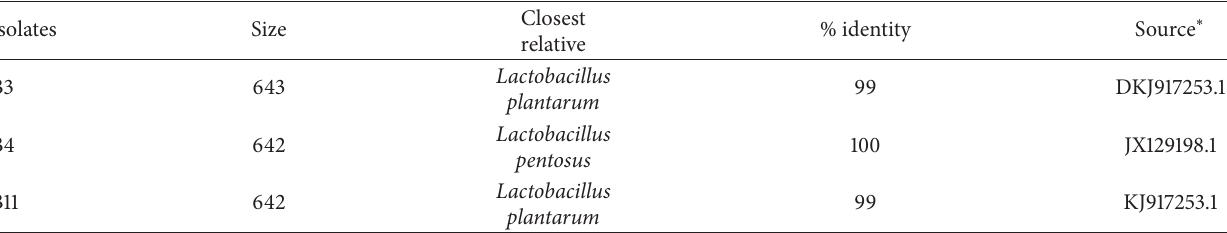
Table 1: Identification of the isolated lactic acid bacteria based on blast comparison in GenBank. ∗ Accession number of the sequence of the closest relative found by blast